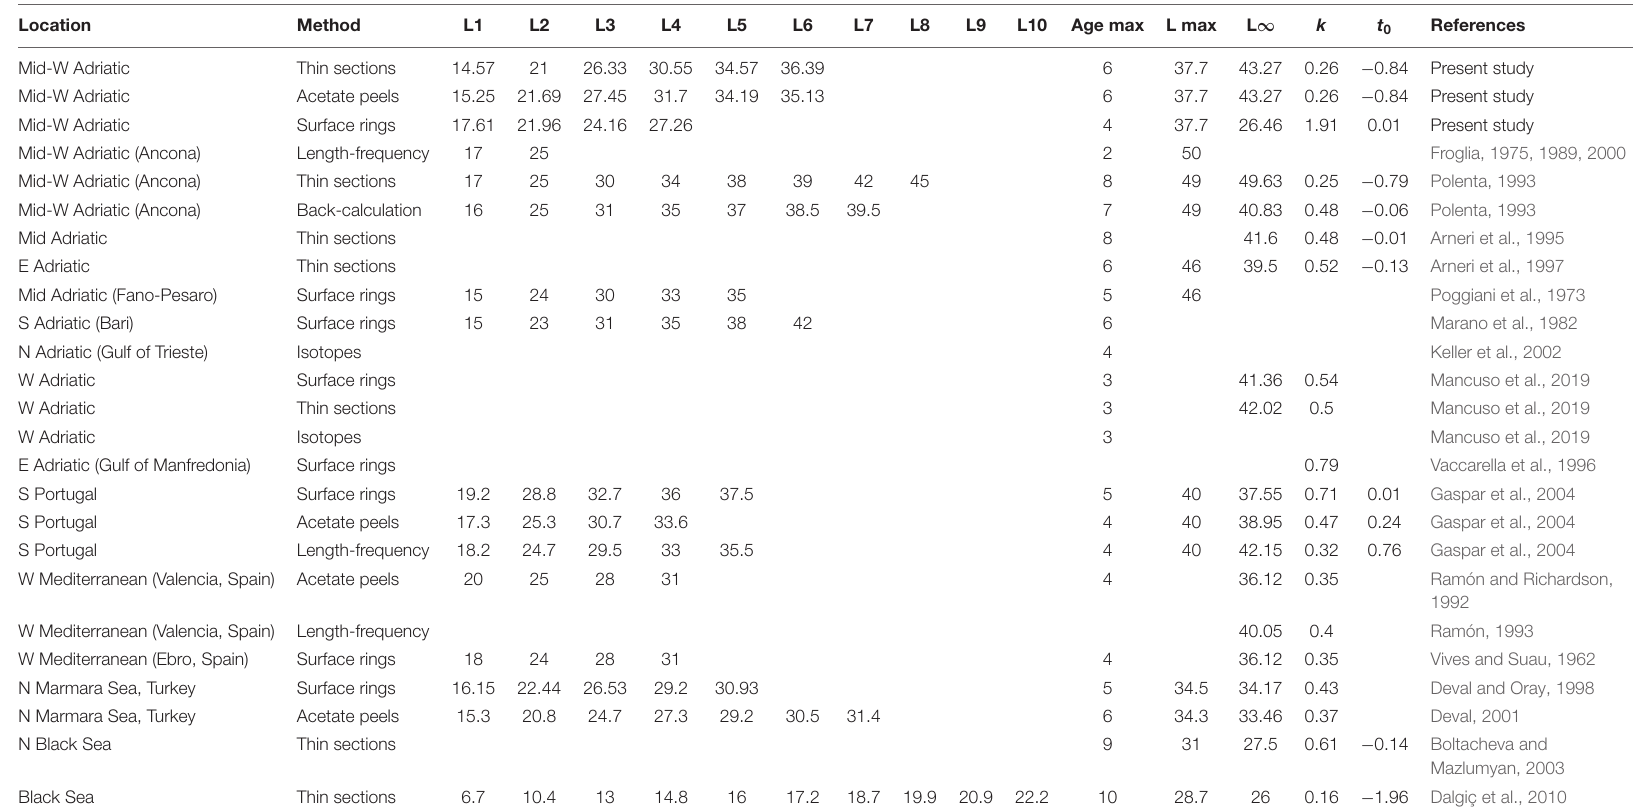
TABLE 4 | Length at age, k, L 8 , t 0 and maximum estimated age values obtained with different aging techniques in C. gallina specimens harvested inside and outside the Adriatic Sea (W, western; E, eastern; N, northern; S,